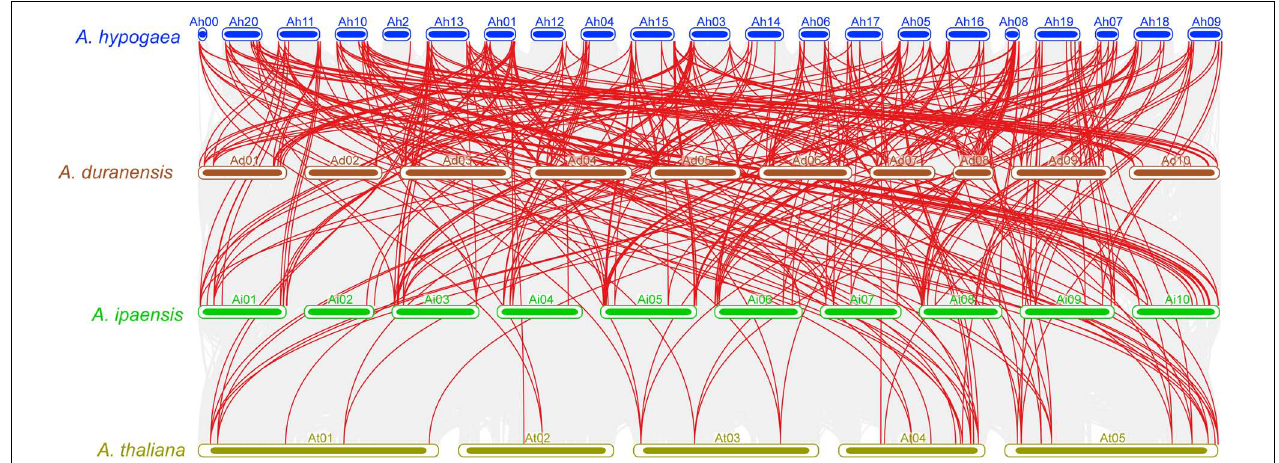
FIGURE 4 | Multiple collinearity analysis of APX genes between A. hypogea, A. duranensis, A. ipaensis, and A. thaliana chromosomes. Gray lines in the background specify the collinear blocks within A. hypogea and other three genomes, while the red lines highlight the syntenic APX orthologous gene